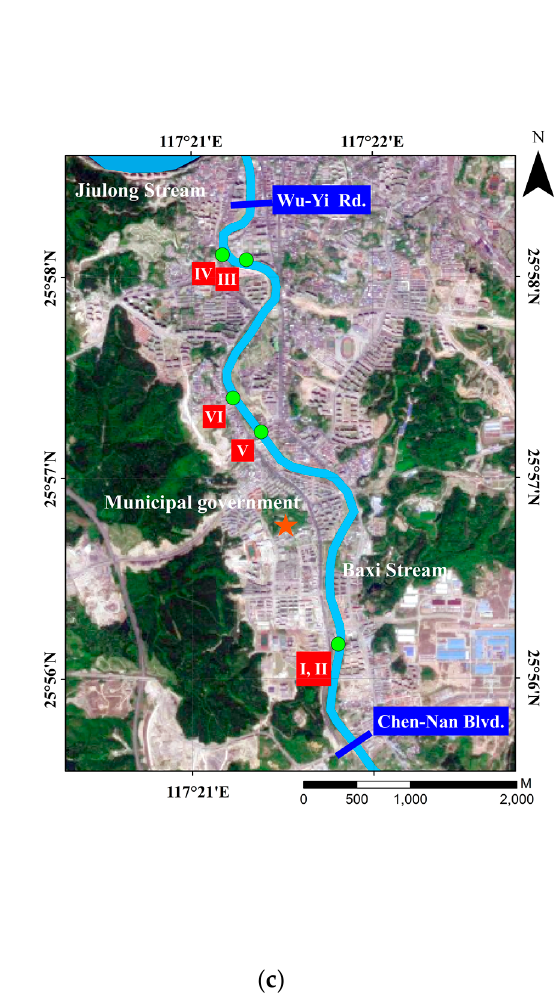
Figure 1. The study area of the Baxi stream (also called Guikou Stream) in Yongan City, Fujian Province, China. ( a ) Location of Yongan City in Fujian Province, China. ( b ) The Baxi stream watershed and study area. ( c ) Investigated reach in the 6.5 km-long downstream section of the Baxi, between Chen–Nan Blvd. and Wu–Yi Rd., passing by the municipal government buildings on the left bank. Six images were collected from sites I, II, III, IV, V, and VI (See Figure 2). The width of the stream in the study area is 40–62 m, and the average gradient of the river is 1/500. According to Strahler’s classification of stream order [52], the portion of Baxi stream in the study area is a third-order stream. Hydraulic structures in the studied